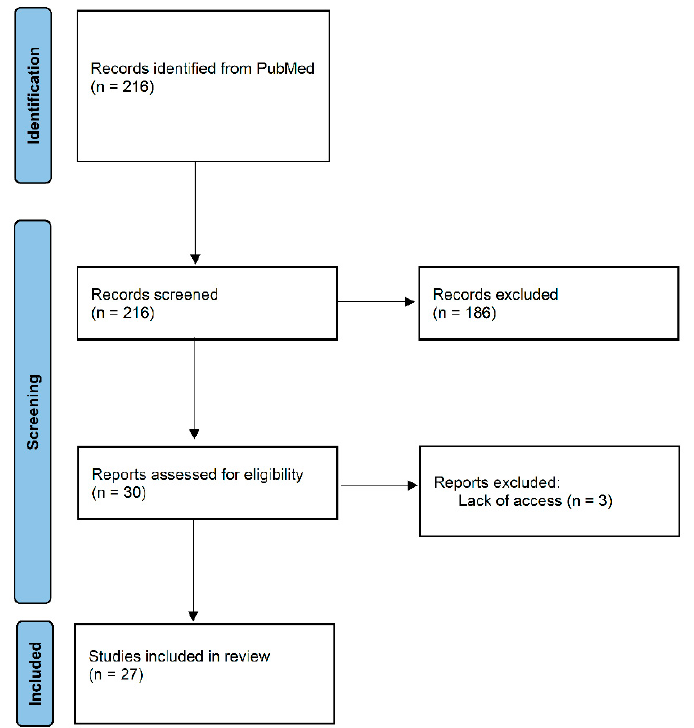
Figure 1. Flowchart showing identification, screening, and inclusion of studies for this